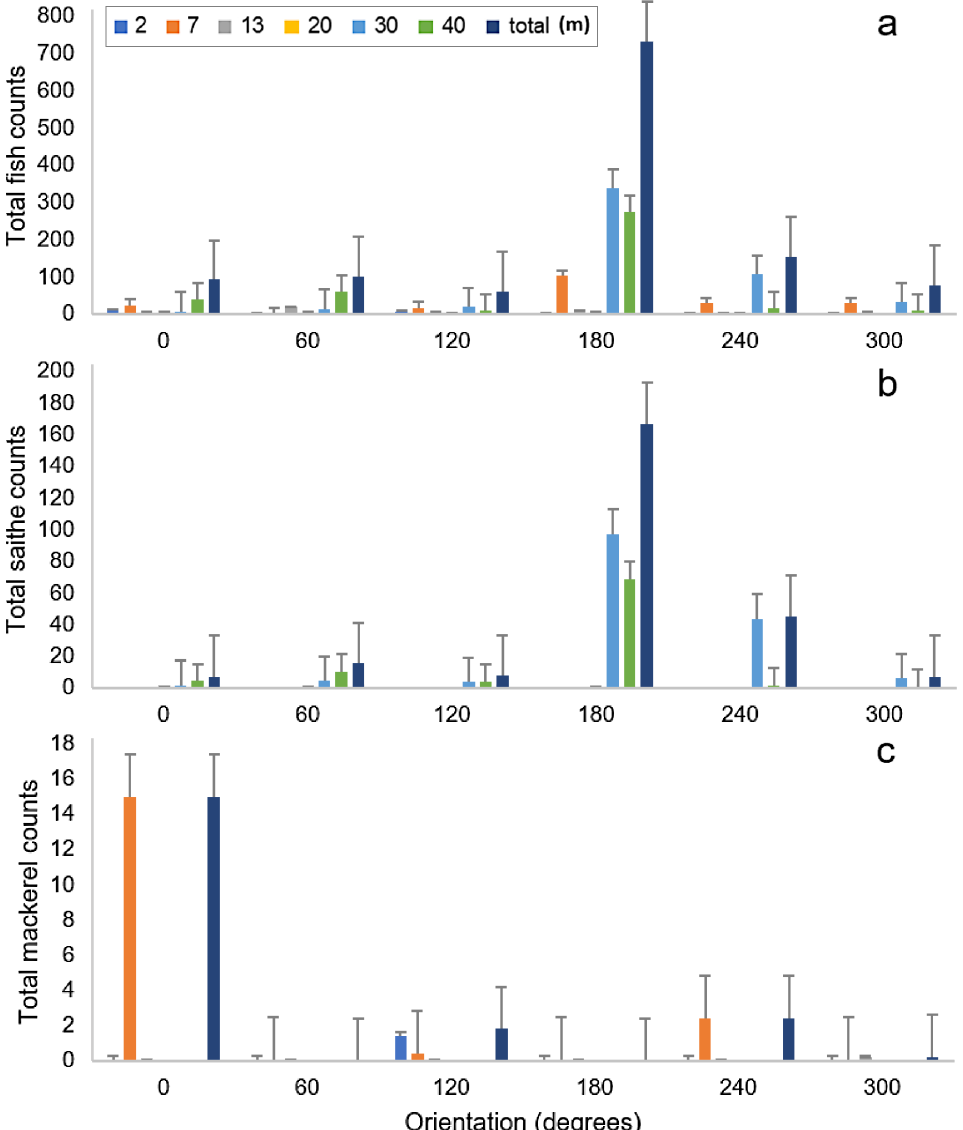
Fig. 6. Average (+SE) number of (a) total manual fish counts, (b) saithe counts, and (c) mackerel counts per day at each filming point around Cage 1 throughout 5 sampling C1, C2, C3, and C4 counted a total of 1660, C3’s counts, and those were excluded from the 1468, 1802, and 1660 fish, respectively, in the calculation of the average fish counts and the stan- same set of 864 images taken around the test dard deviation. cage. The largest difference was between C2 and In total, 1065 fish were detected when images C3. The latter counted 22.8% more fish than C2, without bounding boxes were assessed, while 1119 whereas C1 and C4 had exactly the same total fish fish were detected when images with the bounding counts. However, on a single image basis, the boxes were checked. C1 detected 4.8% more fish number of detected fish also differed between C1 when bounding boxes were present on the images. and C4 as well as among all the counters (Fig. 7). work was significantly different when images were examined with and without bounding boxes (Wil - coxon signed-rank test, p < 0.001).